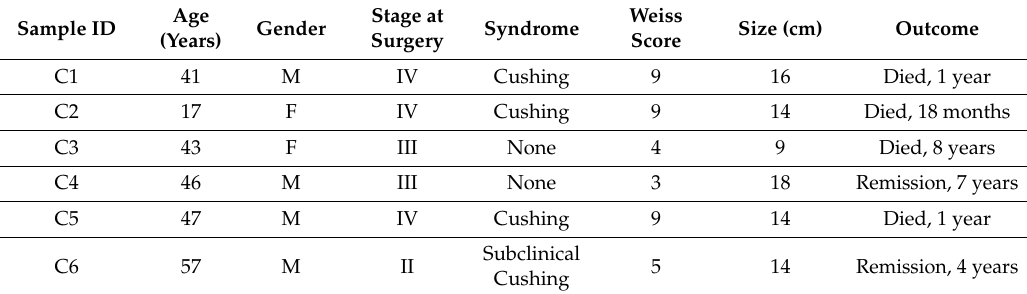
Table 1. Clinical data of the six ACC patients analyzed in this